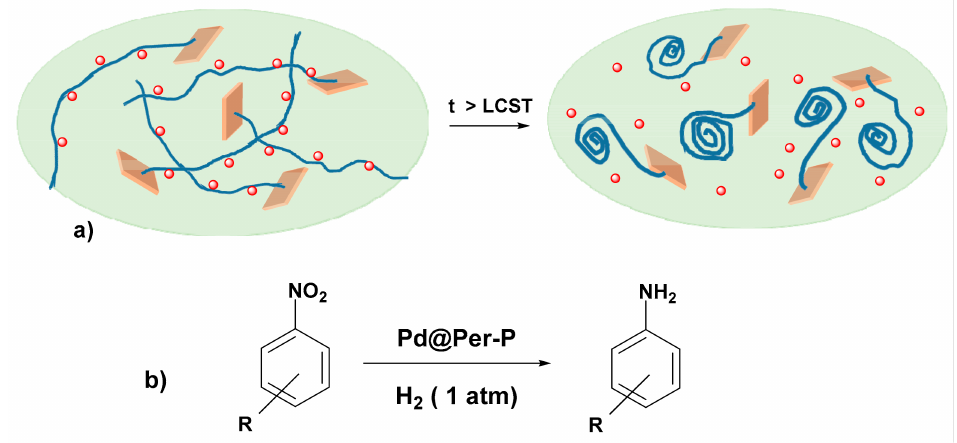
Figure 10. ( a ) Schematic representation of the structural change of Pd@Per-P at temperature above LCST. ( b ) Hydrogenation of